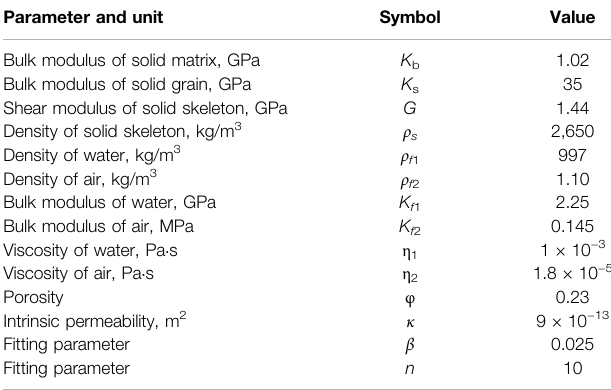
TABLE 1 | Parameters of Massillon sandstone containing air and water (Tuncay and Corapcioglu, 1996). Parameter and